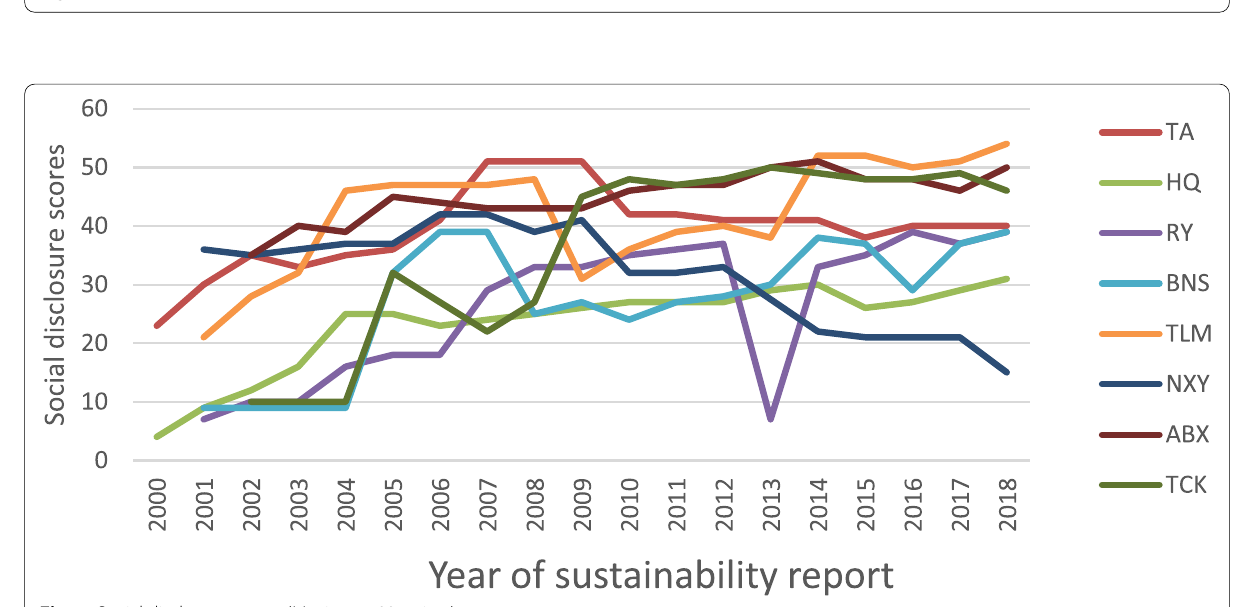
Fig. 5 Social disclosure scores (Maximum 83